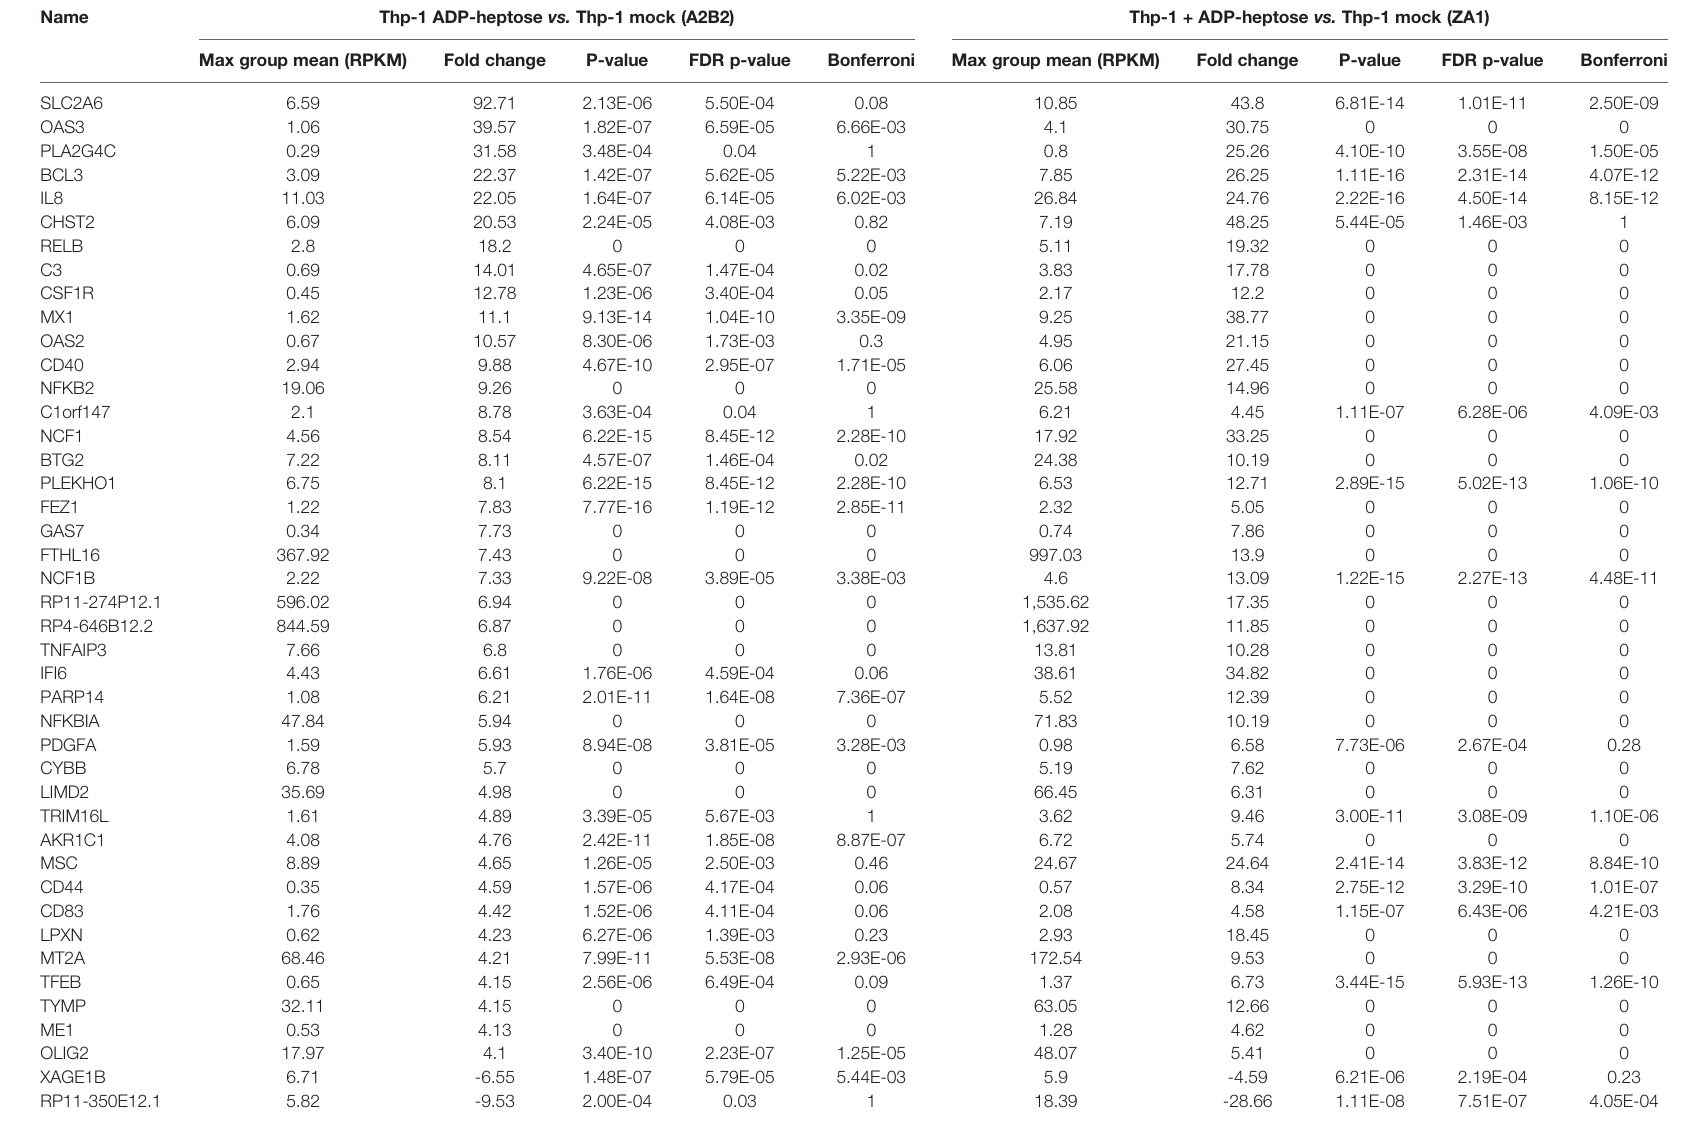
TABLE 4 | Selected human gene transcripts regulated by ADP-heptose co-incubation of human monocyte/macrophage cells line Thp-1 (cut-off of fourfold regulated in comparison to mock, from two independent experiments [biological replicates]).